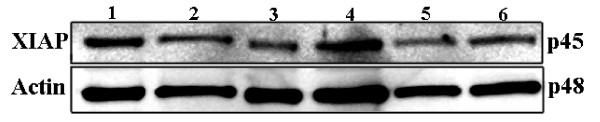
Expression of XIAP in melanoma cell lines. XIAP expression was determined by western blot analysis in 7 melanoma cell lines, ordered left to right: Mel 624 AB, Mel 624 MC, Mel 501, Mel 888, YUGEN8, YUMAC, MM127.